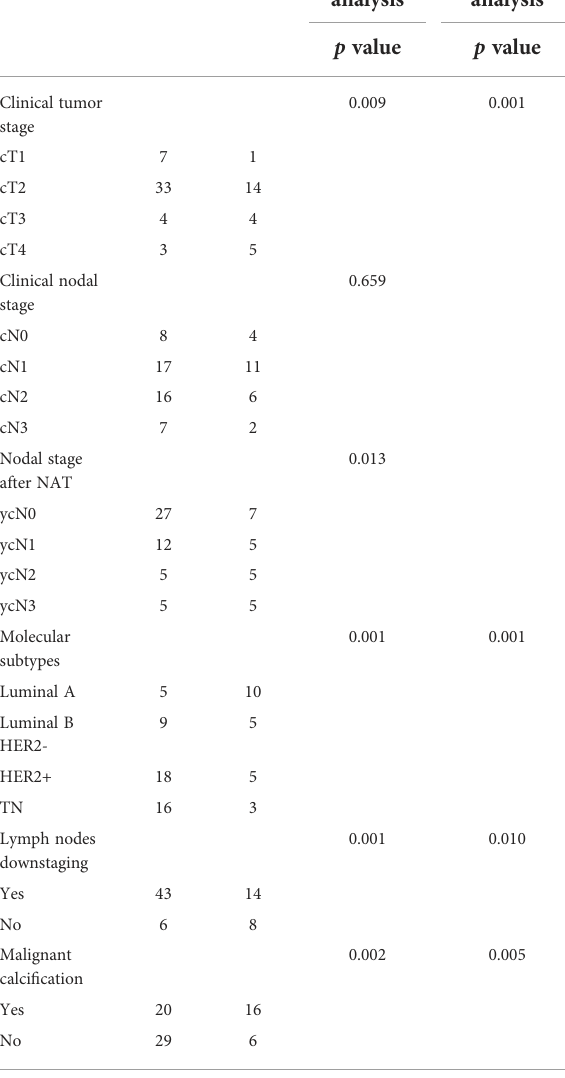
TABLE 7 The predictive factors for modi fi ed shrinkage classi fi cation modes after NAT in the training cohorts. Factors MCSM MNCSM